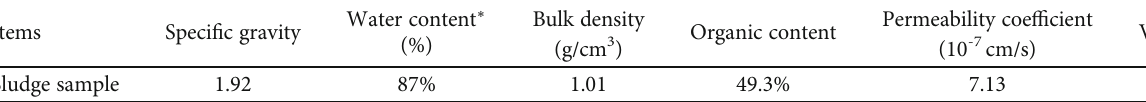
Table 1: Characteristic of sludge sample.